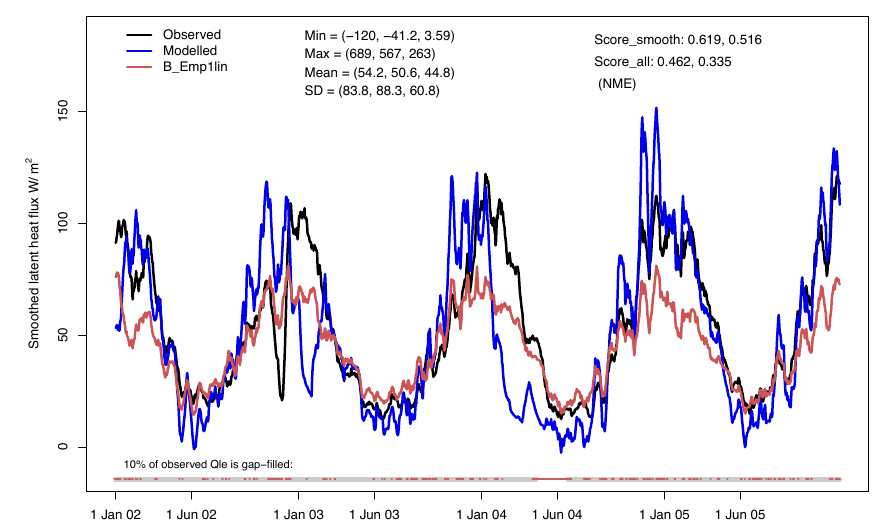
Fig. 1. A 14-day running mean latent heat flux time series at a single flux tower site. While model performance (blue) relative to obser- vations (black) look very good, many metrics on this time series show that an out-of-sample linear regression (red) of latent heat against short-wave radiation performs